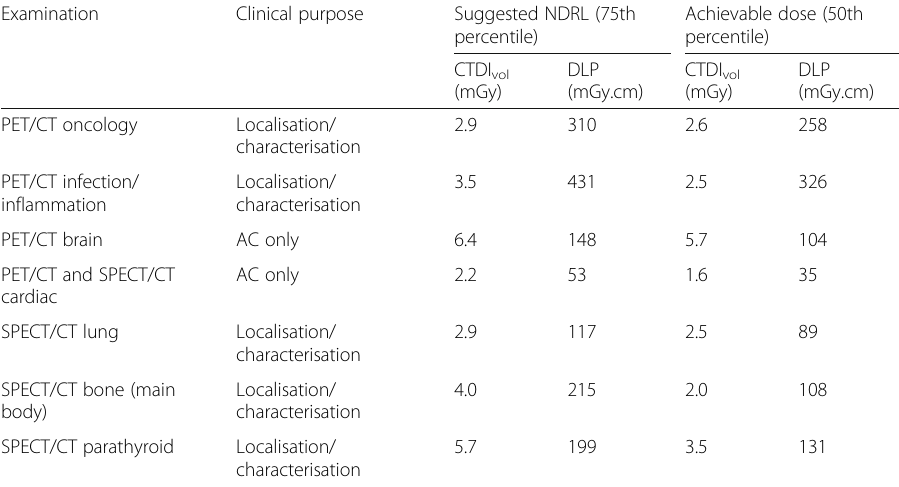
Table 1 Suggested NDRL and achievable doses for PET/CT and SPECT/CT examinations according to clinical purpose (Mean DLP data (not weight-derived) normalised to a 16-cm CTDI phantom are given for PET/CT brain; NDRL and achievable doses are not presented for PET/CT oncology diagnostic CT scans as standalone diagnostic NDRLs should be used for